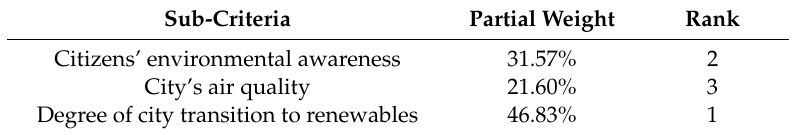
Table 11. Sub-criteria relative weight and rank of environmental conditions of the city.